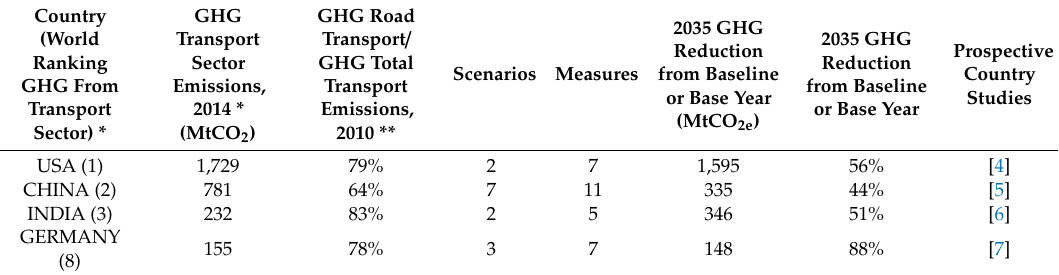
Table 1. Countries with the highest proportion of global greenhouse gas (GHG) emissions in the world transport sector and the high ambition GHG reduction prospective country studies in this sector. Country